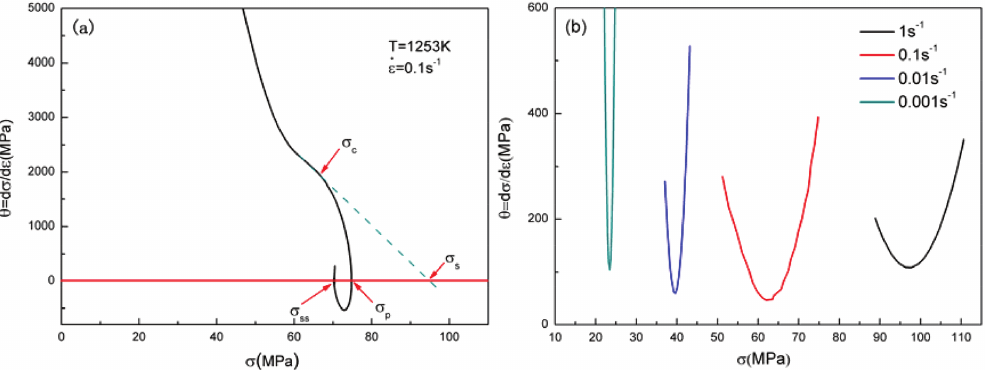
Figure 9: (a) Relationship between θ and σ at temperature of 1,253 K and strain rate of 0.01 s – 1 ; (b) Relationship between – d θ /d σ and σ at different strain rates under temperature of 1,253 K.